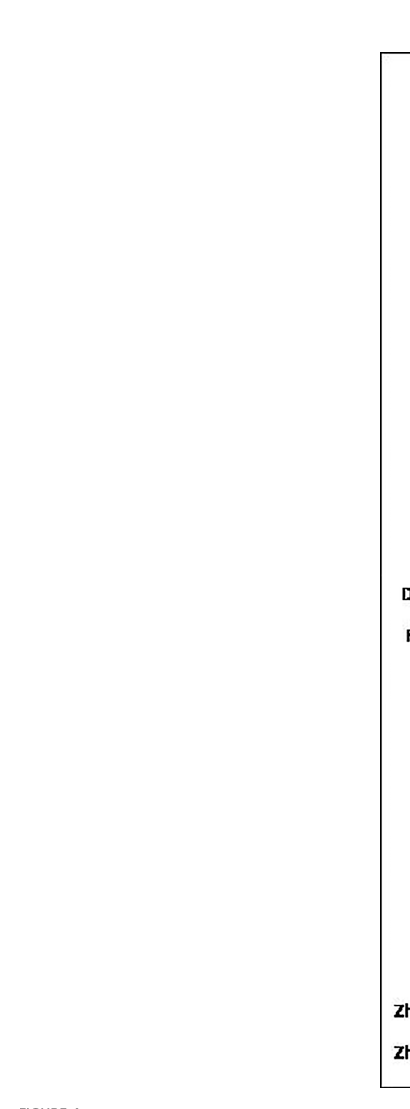
FIGURE 4 The evaluation results of article quality were